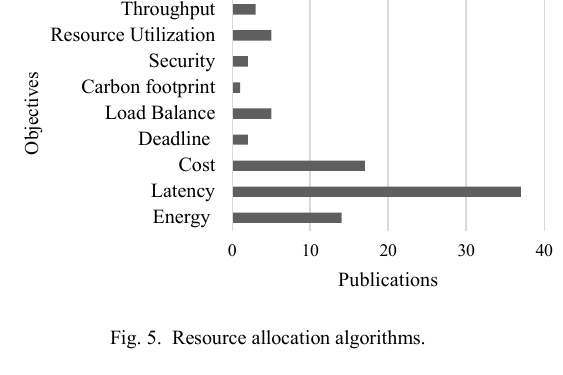
Fig. 5. Resource allocation algorithms.